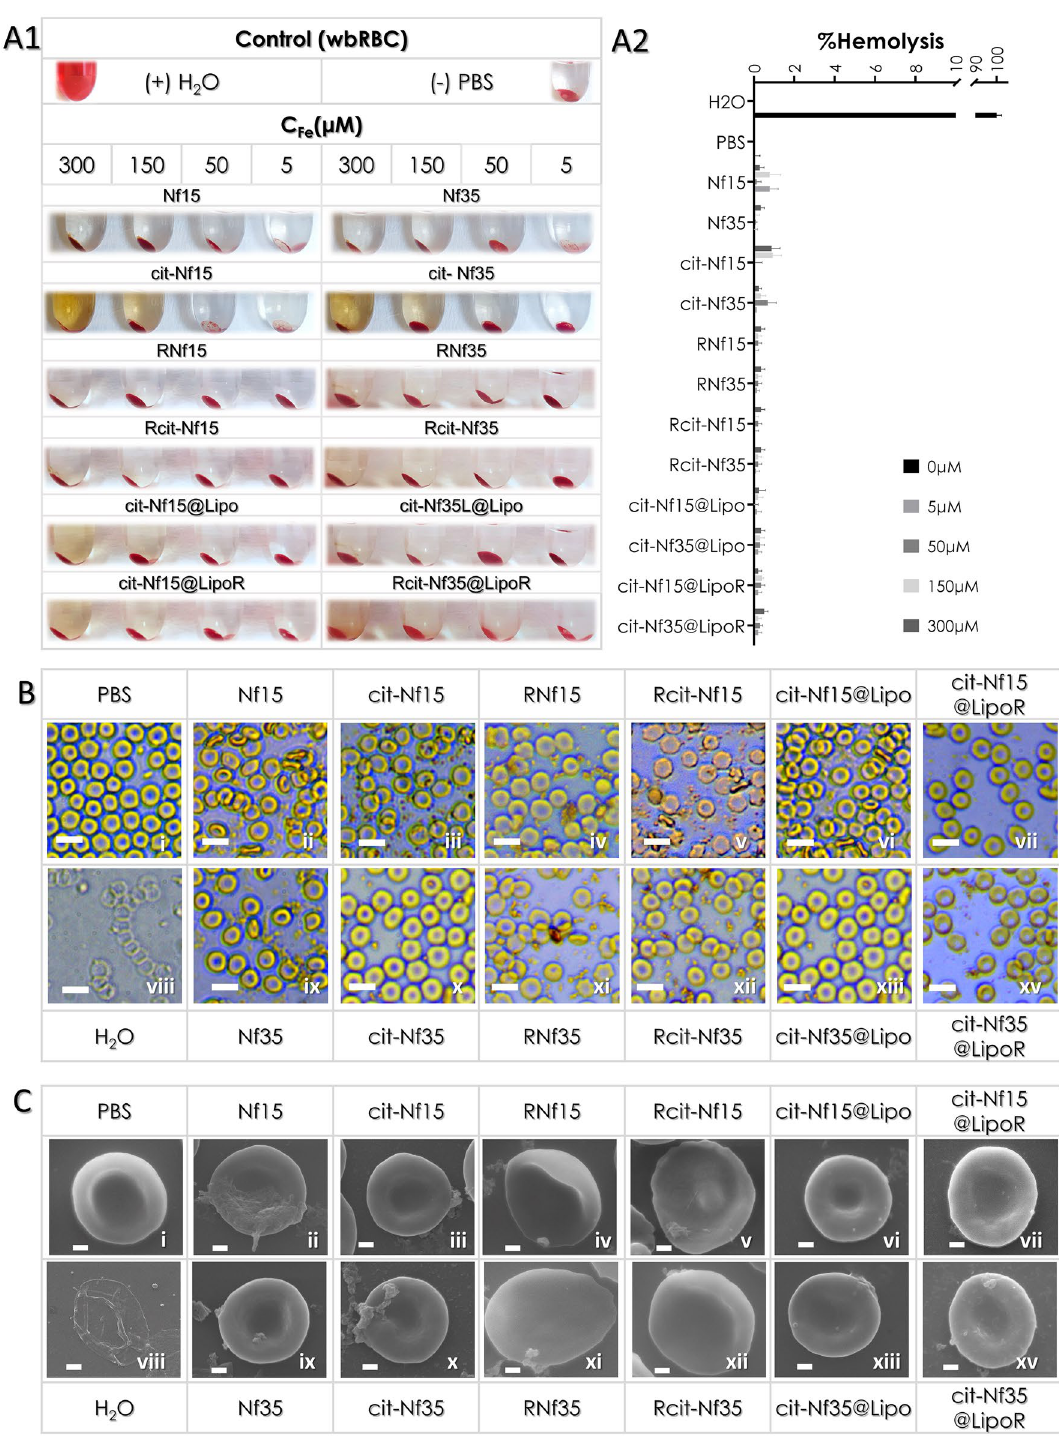
Figure 4. Whole blood RBCs: ( A1 ) Optical assessment of hemolysis and ( Α2 ) hemoglobin percentage present in each supernatant after 3 h incubation with the samples at different concentrations as measured in ELIZA, ( B ) Optical microscopy (scale bars at 10 μm) and ( C ) SEM images (scale bars at 1 μm) of RBCs after 3 h incubation with the samples at a selected concentration (150 μΜ) on coverslips in 24-well